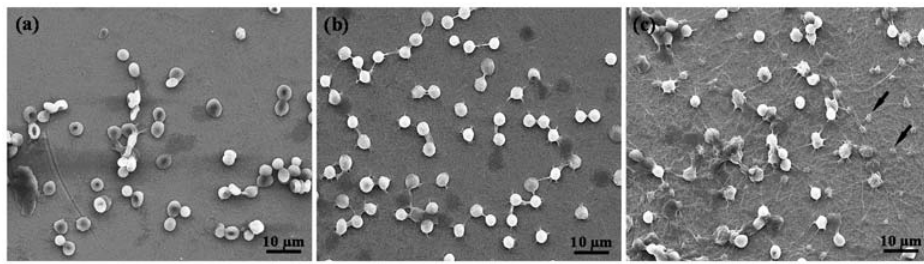
Figure 6. The FE ‐ SEM images of red blood cells’ (RBCs) morphology from the control sample and plasma ‐ oxidized samples after blood contact for 20 min: ( a ) the control sample; ( b ) the sample plasma ‐ oxidized at 160 W for 30 min; and ( c ) the sample plasma ‐ oxidized at 280 W for 30 min.